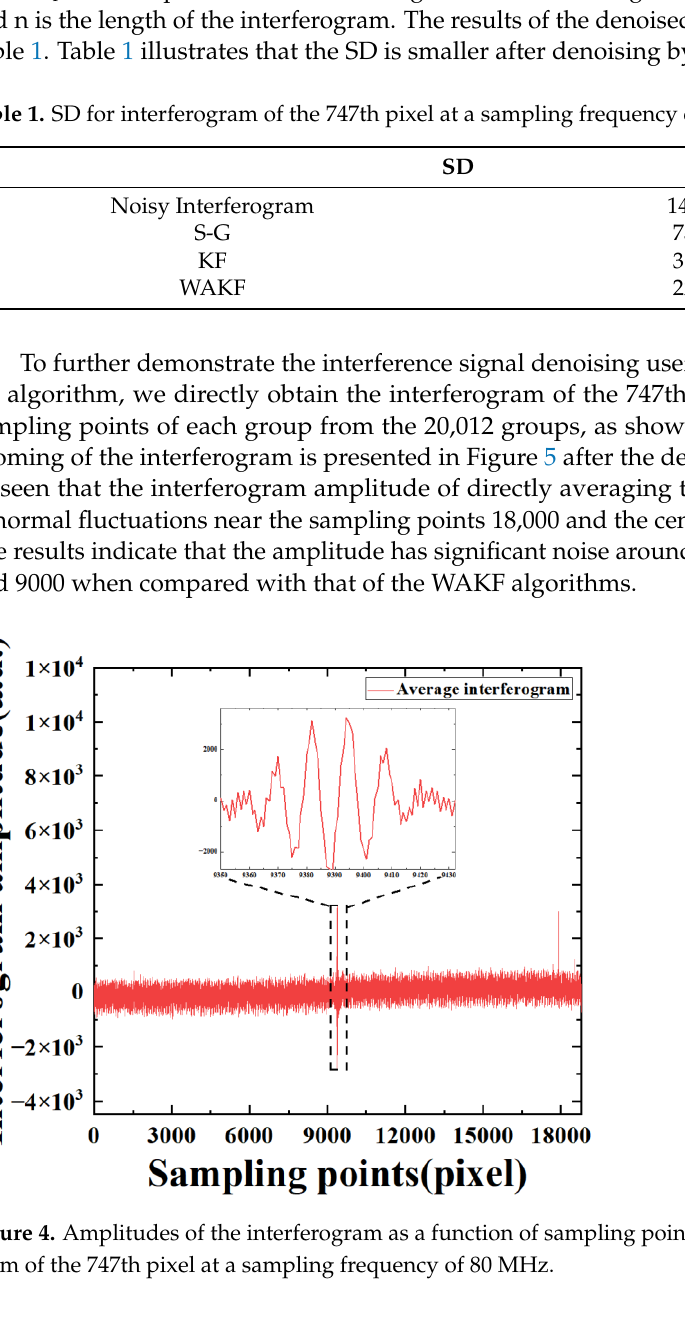
Figure 5. The amplitudes of the step interferogram as a function of sampling points are denoised with WAKF for the 747th pixel at a sampling frequency of 80 MHz. Next, we discuss the reliability and accuracy of the denoising methods. The interfer- ence signals of the 355th pixel at 125 MHz sampling frequency are denoised by using S- G, KF and WAKF. The real signals are completely concealed in the noise distribution from the whole data, as shown in red in Figure 6. The denoising results after using the S-G, KF and the proposed WAKF are also shown in Figure 6. It can be seen that most noises are reduced in blue and green. Additionally, the results indicate that the denoising of our improved WAKF is better than that of KF. The conclusion is also reflected in the SD result, as shown in Table 2. Here, one can see that the SD of the WAKF is minimal. It can be concluded that our proposed WAKF is more effective than KF in recovering signal char- acteristics. In combination with the sampling points of the 747th pixel at an 80 MHz fre- quency, the SDs of interferograms with our WAKF are smaller than those with the KF by